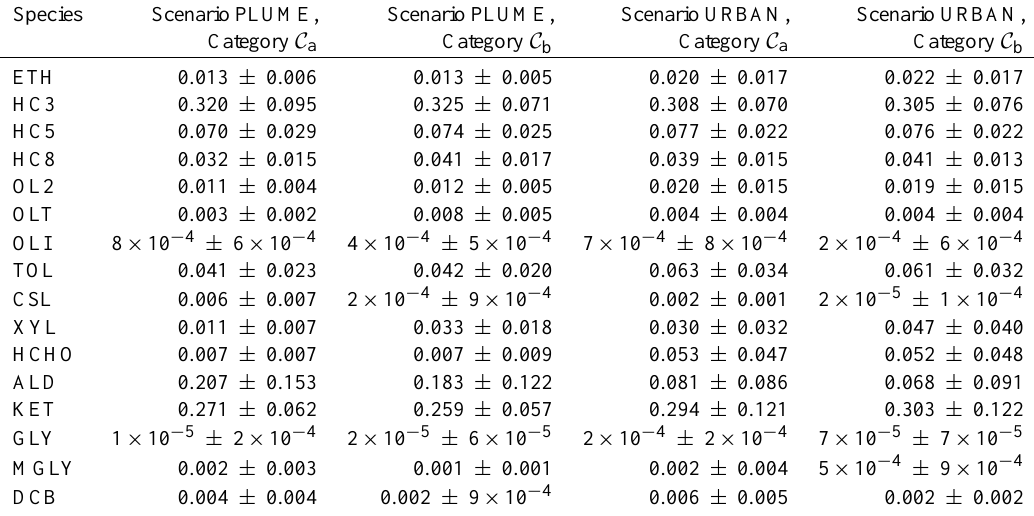
Table 8. Mean impact and standard deviation of VOCs for categories C a and C b . Considered are optimal projected relative singular vectors with respect to initial uncertainties and final projection on O 3 and